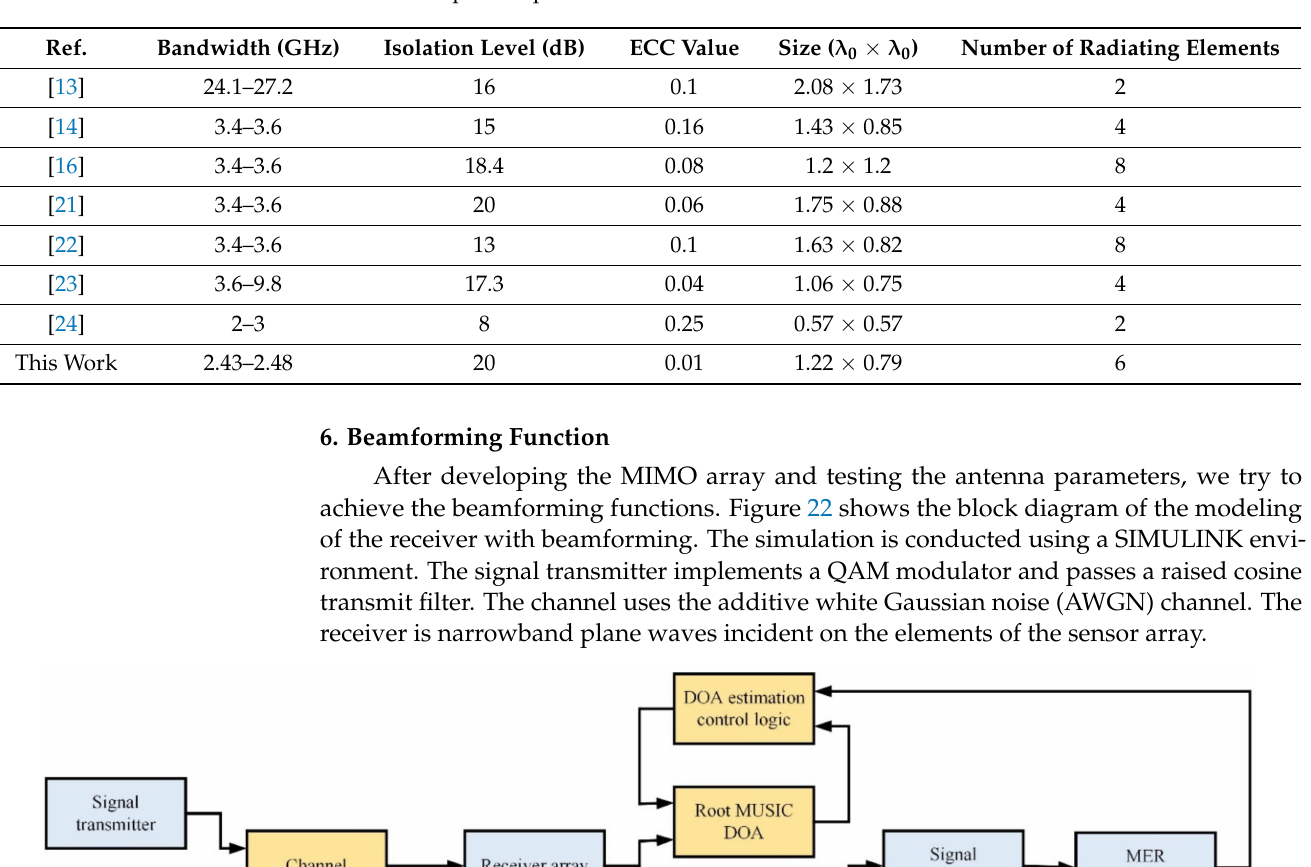
Table 1. Comparison performance.